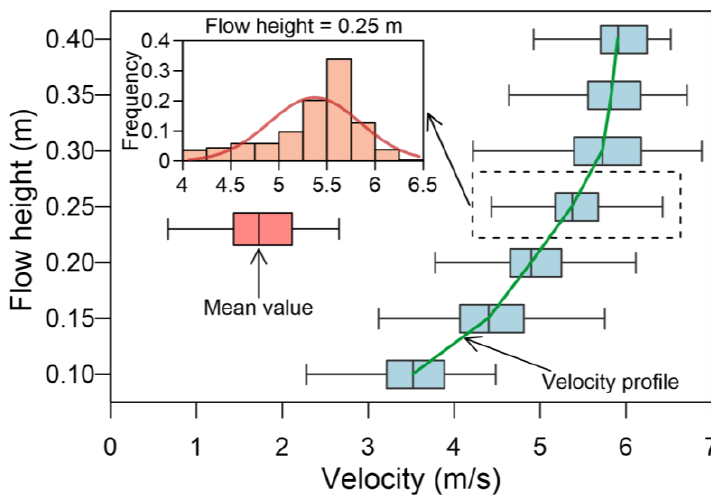
Figure 5. The boxplot of the single-layer particle velocity profile.